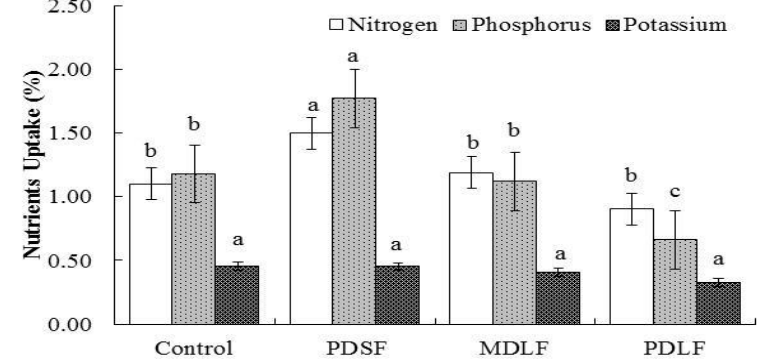
Figure 4. Effect of PDSF, MDLF, and PDLF fulvic acids (FA) on plant nutrients uptake of the maize crop; error bar shows the standard error of means ( n = 4). The least significant differences (LSD 0.05 ) are at 5% level of significance, different letter on top of each bar showing significant differences between treatments.